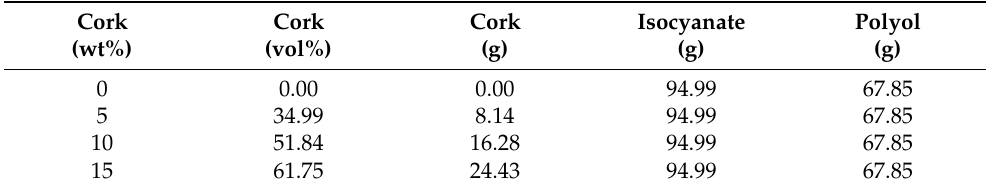
Table 2. Mix design of polyurethanes containing increasing content of cork waste (from 0 wt% to 15